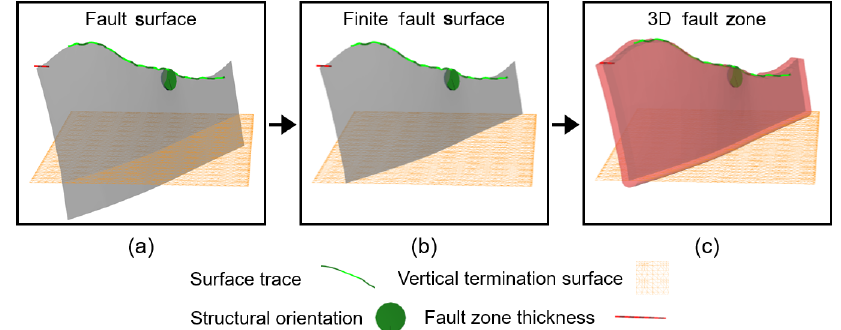
Figure 1. The proposed fault zone modeling workflow implemented includes (a) modeling the central fault surface from a polyline and structural orientation, (b) terminating the fault surface on a predefined vertical termination surface, and (c) defining the 3D fault zone volume using a distance function from the central fault surface (Krajnovich et al.,